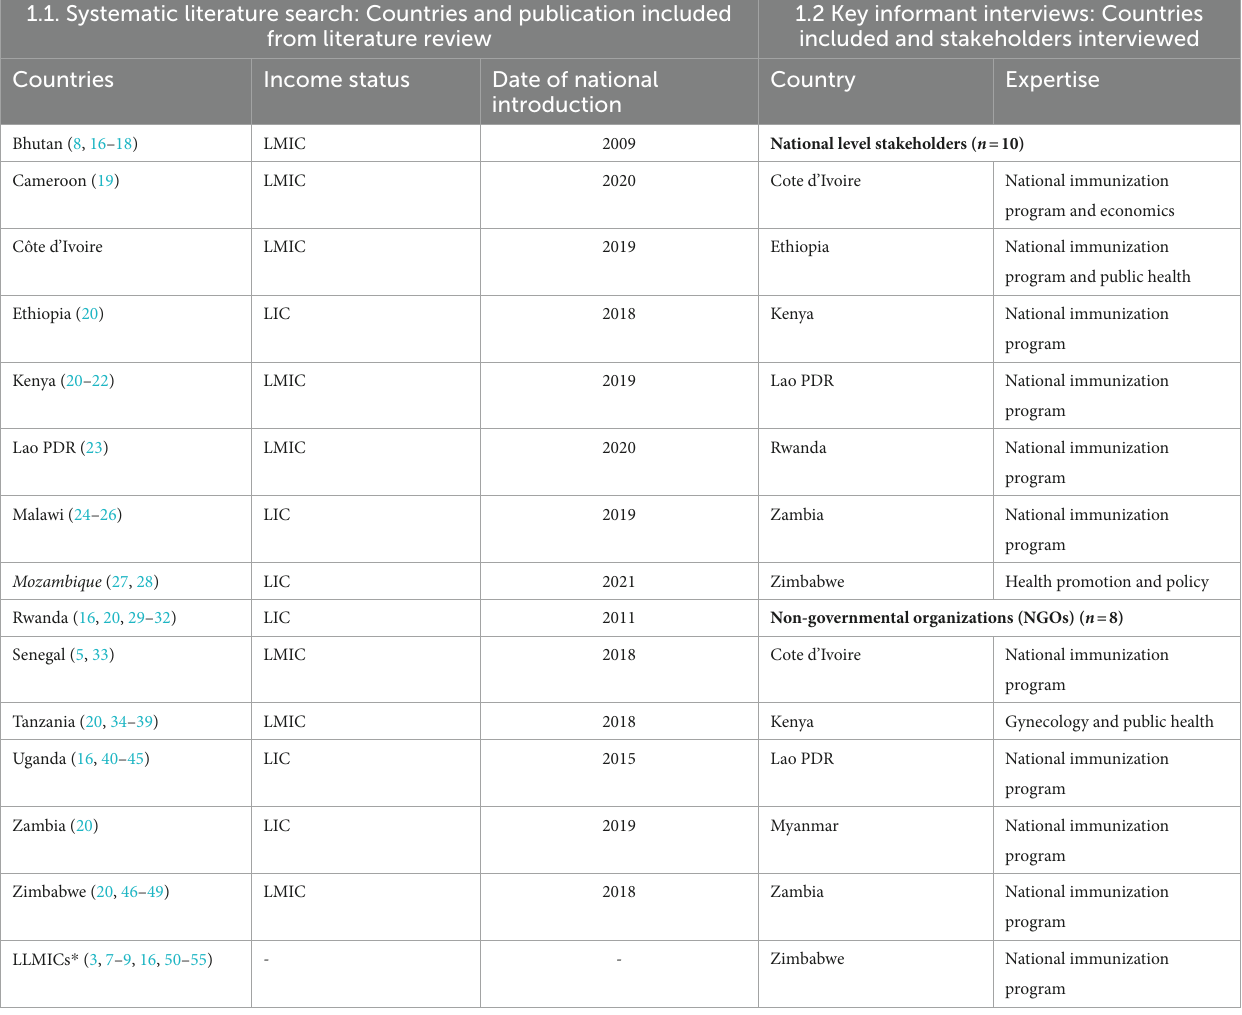
TABLE 1 Overview of countries included in systematic literature search and stakeholder interviews. 1.1. Systematic literature search: Countries and publication included from literature review